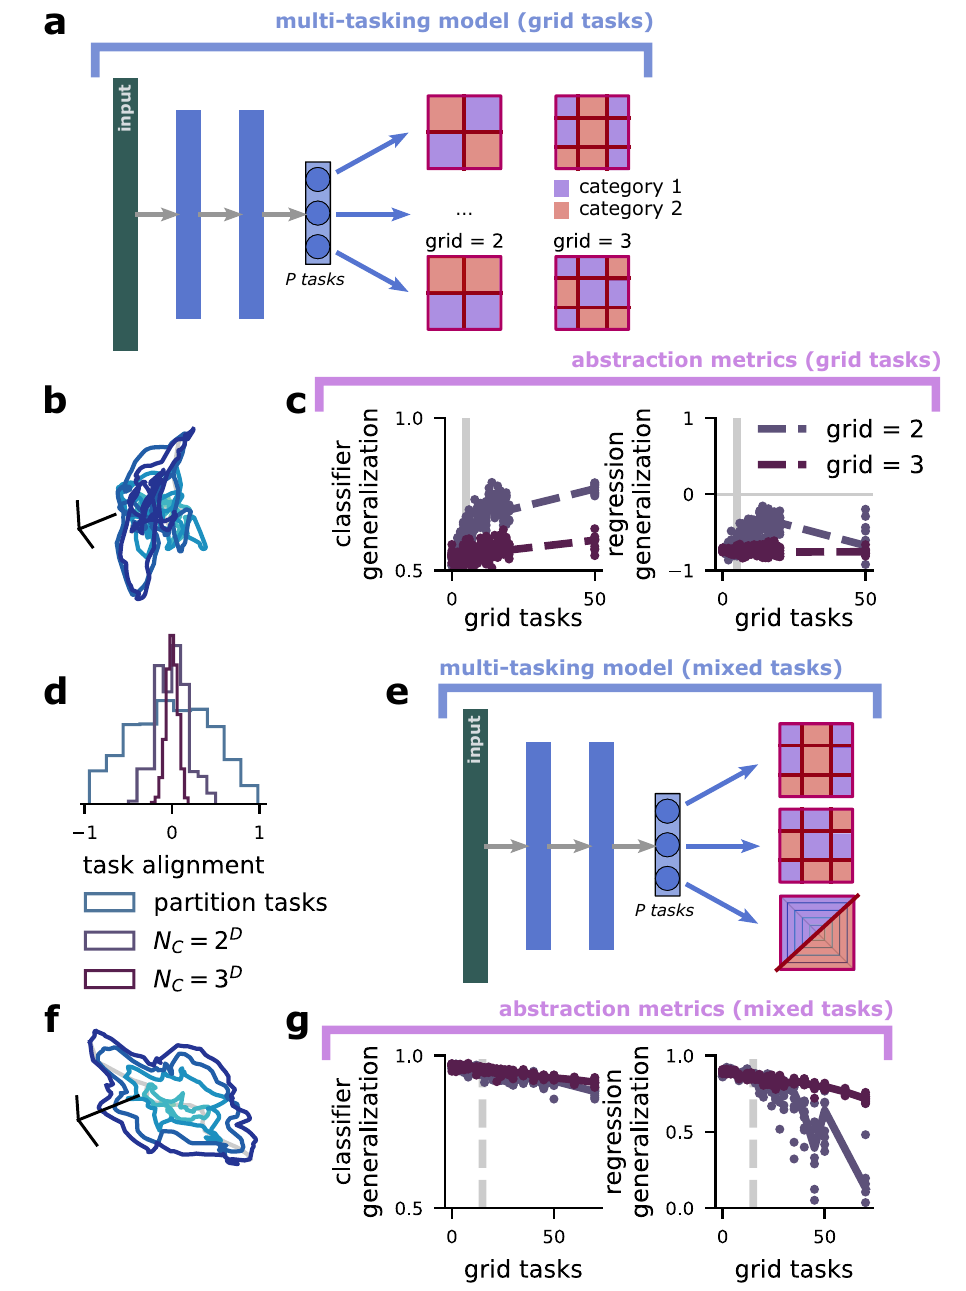
Fig. 4 | Abstract representations emerge for heterogeneous tasks, and in spite of high-dimensional grid tasks. a Schematic of the multi-tasking model with grid tasks. They are de fi ned by the grid size, grid, the number of regions along each dimension (top: grid=2; bottom: grid=3), and the number of latent variables, D . There are grid D total grid chambers, which are randomly assigned to category 1 (red) or category 2 (blue). Some grid tasks are aligned with the latent variables by chance(asintopleft),butthisfractionissmallforevenmoderate D . b Visualization oftherepresentationlayerofamulti-taskingmodeltrainedonlyongridtasks,with P =15. c Quanti fi cation of the abstraction developed by a grid task multi-tasking model. (left) Classi fi er generalization performance. (right) Regression general- ization performance. d The alignment (cosine similarity) between between